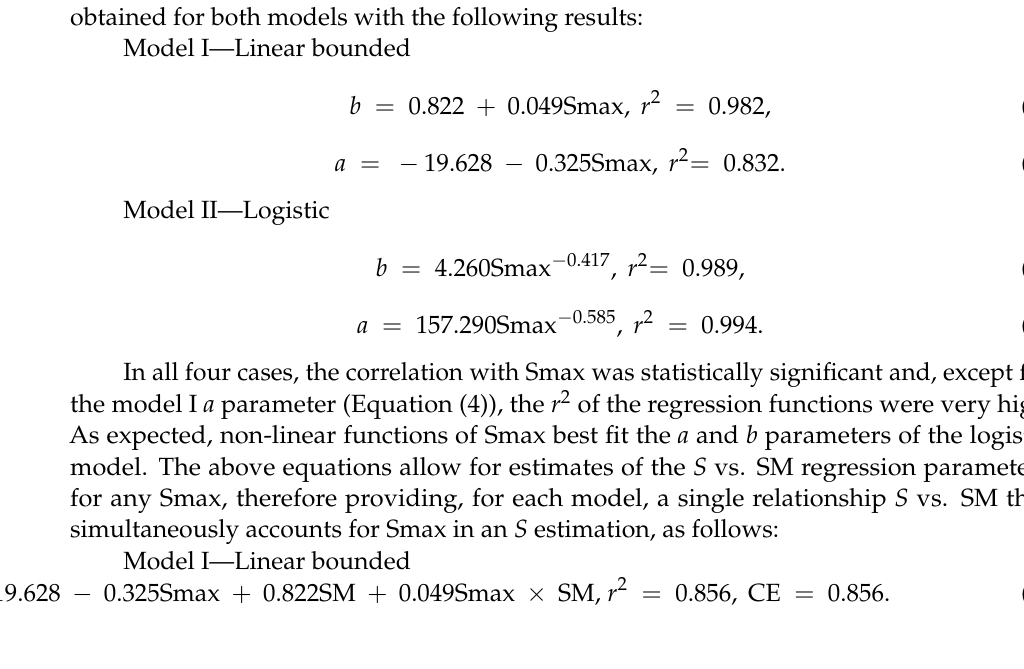
Figure 7. Model performance in the range of Smax tested, comparing linear model (I) with the logistic model (II): ( a ) determination coefficient ( r 2 ) and ( b ) standard error of the estimate (SEE, %Smax).